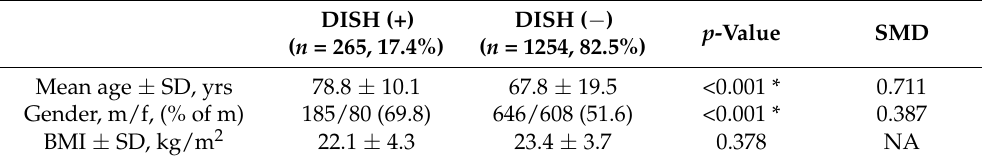
Table 1. Patients’ demographic data.